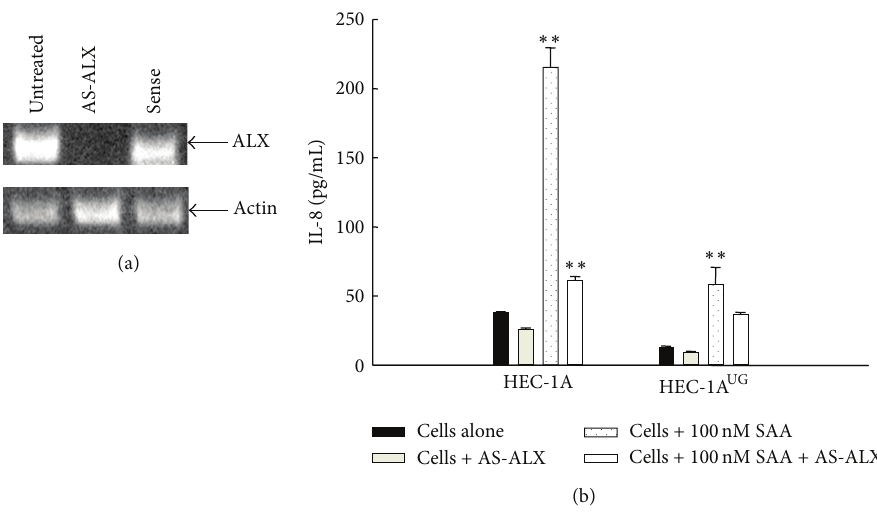
Figure 3: SAA-induced IL-8 levels were significantly downregulated in HEC-1A cells overexpressing UG. (a) Reverse transcription-PCR of ALX mRNA in HEC-1A cells and ALX-antisense (AS-ALX) oligo-treated HEC-1A cells. The result is from a representative gel of two performed. (b) SAA-dependent IL-8 release as measured by ELISA, in HEC-1A cells, is inhibited when pretreated with ALX-antisense oligo. In HEC- 1 A UG cells SAA-induced IL-8 release is significantly lower in comparison to HEC-1A. Student’s 𝑡 -test for SAA versus AS-ALX treated HEC-1A cells or HEC- 1 A UG cells was calculated, 𝑃 < 0.0001 ( ∗∗ ). Data were normalized using number of cells. Results are the mean ± SD of three separate experiments with quadruplicate determinations.